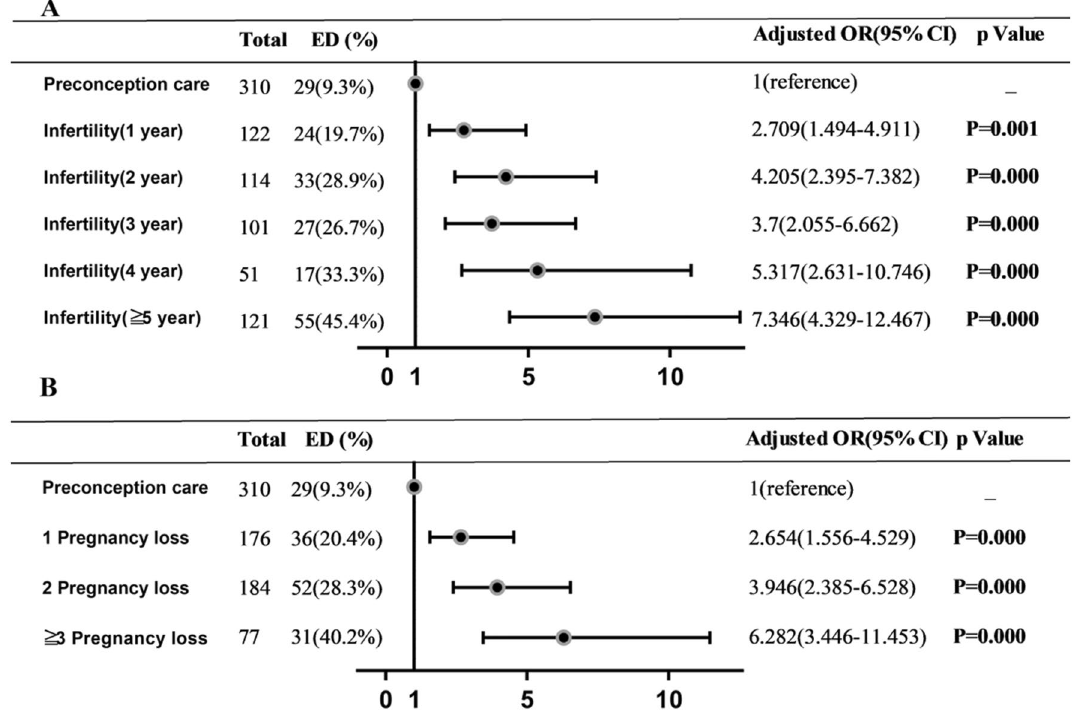
Figure 1. Multivariable logistic regression analysis of infertility duration ( A ) and PL frequency ( B ) associated with ED—all odds ratios in comparison to preconception care group and adjusted for